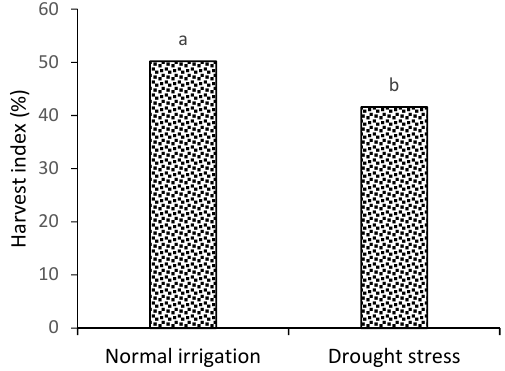
Fig 7. The effect of irrigation regime on harvest index. Means by the uncommon letter in each column are significantly different according to Duncan test (p<0.05).